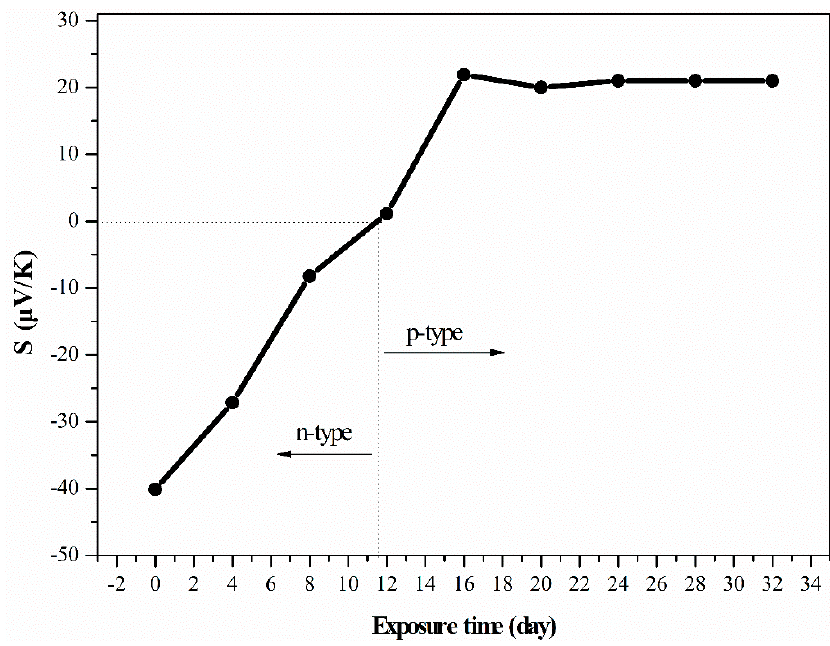
Figure 6. Seebeck coefficient of the SWCNT/PEI-15 composite as a function of exposure time in an ambient environment.